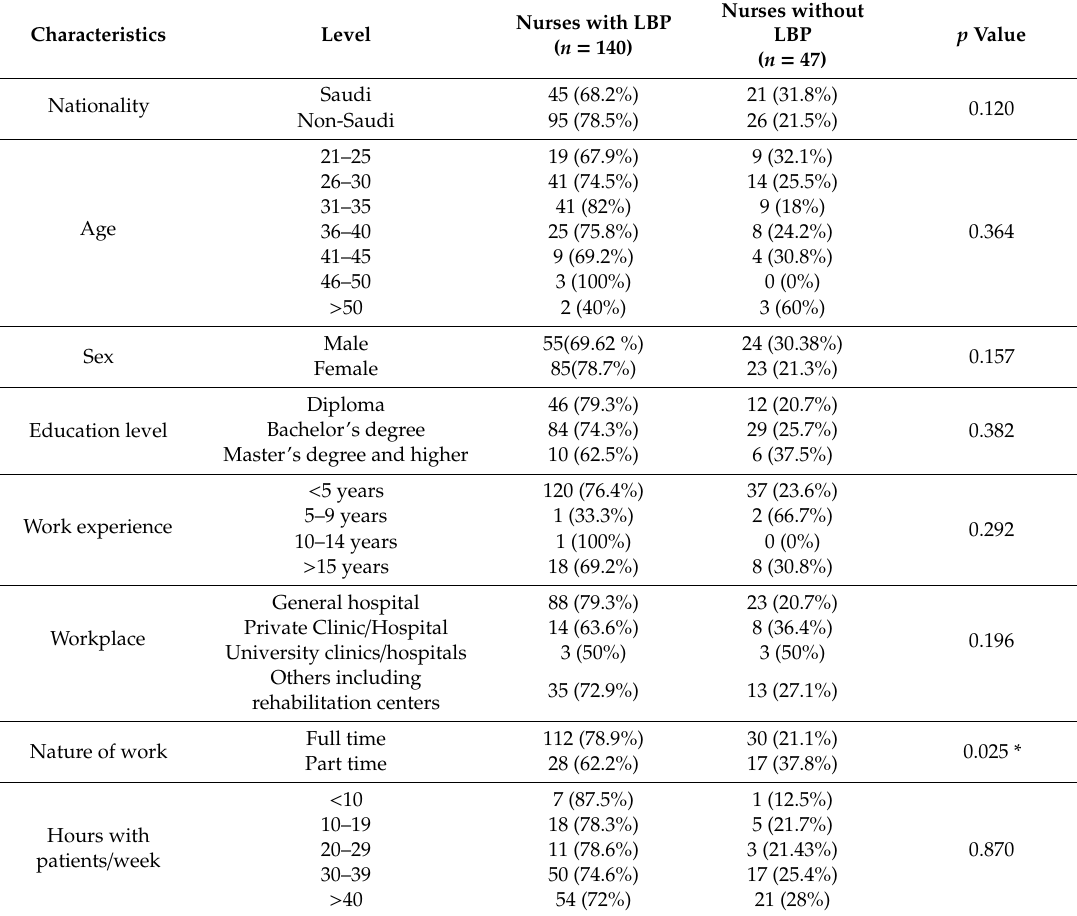
Table 2. Sociodemographic and work-related characteristics and their association with low back pain.